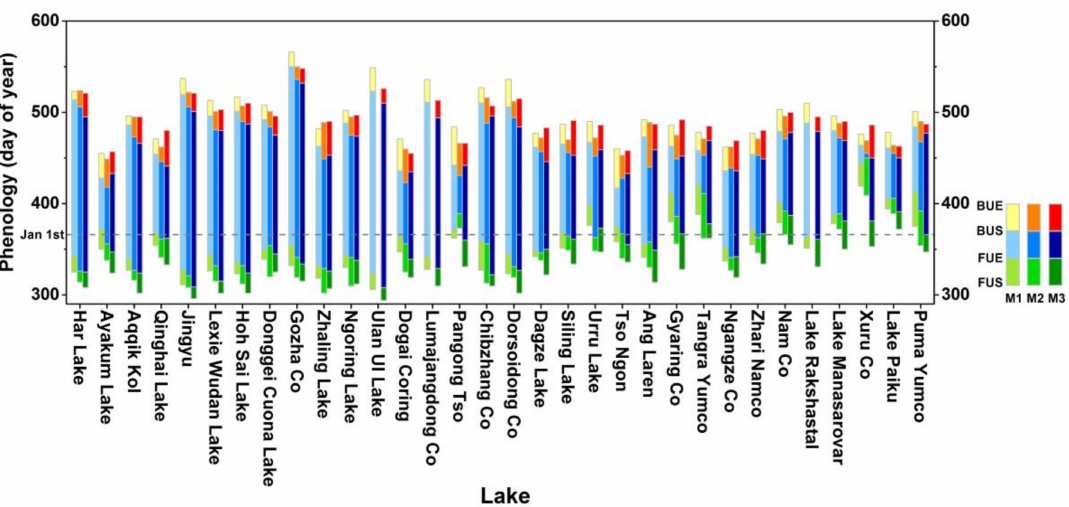
Figure 2. Dates of ice phenology of the studied lakes. (Lakes were sorted by latitude. M1, M2, and M3 respectively represent the methods described in Sections